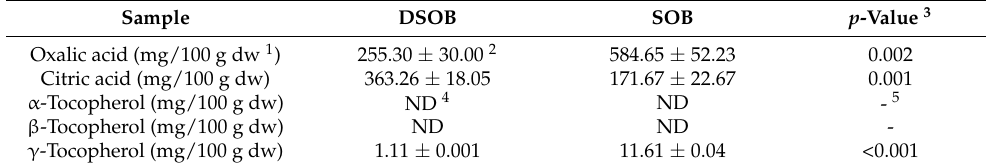
Table 9. The contents of oxalic acid, citric acid, and tocopherols in defatted seeds of Oenothera biennis (DSOB) and seeds of Oenothera biennis